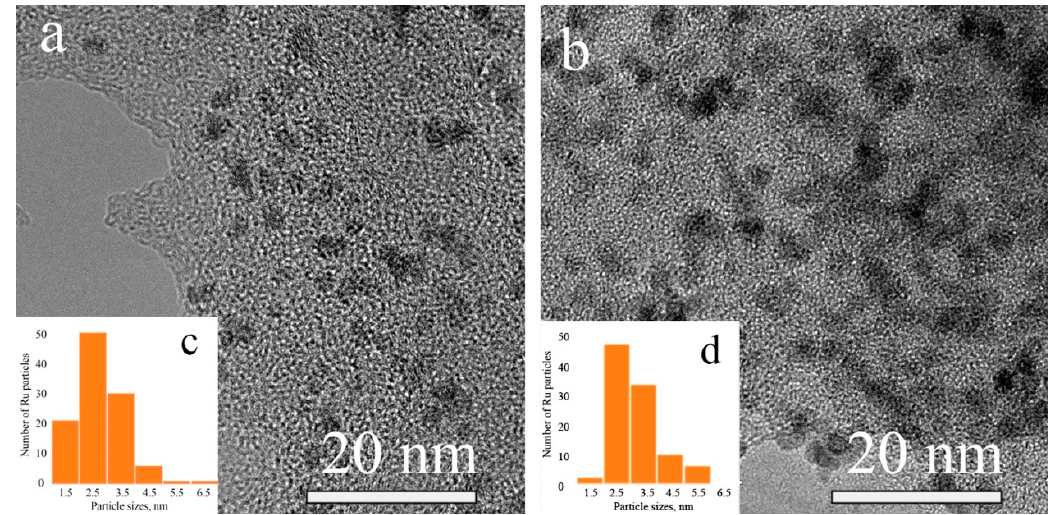
Figure 2. TEM images of Ru-PPP ( a ) and Ru-PPP-S ( b ) and Ru nanoparticles size distribution histograms for Ru-PPP ( c ) and Ru-PPP-S ( d ).